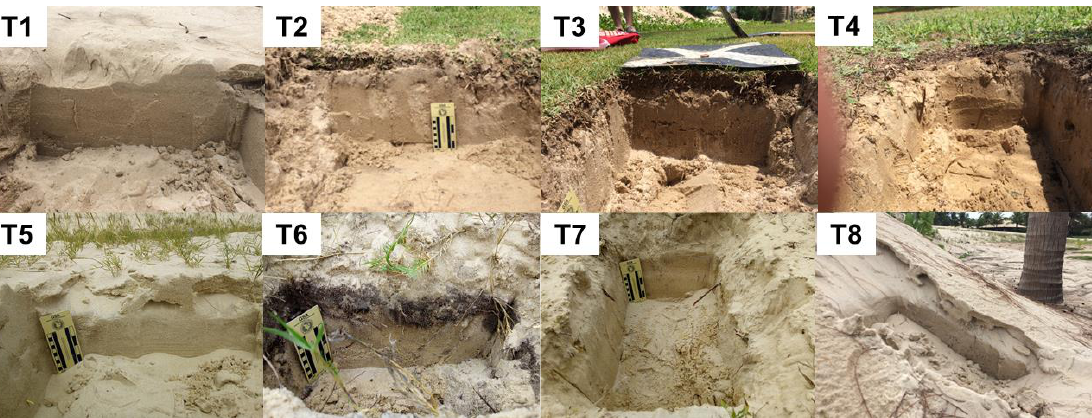
Figure 11. Trenches show planar strata T1, T5, T6, and T7, cut in almost stabilized deflection surface. The presence of roots and fragments of vegetation, and a soil level in the sections dug on the stabilized deflation surface (T2, T3 and T4) and also in T6. T8, trench cut into the face of an active depositional lobe. Cumbuco Beach.